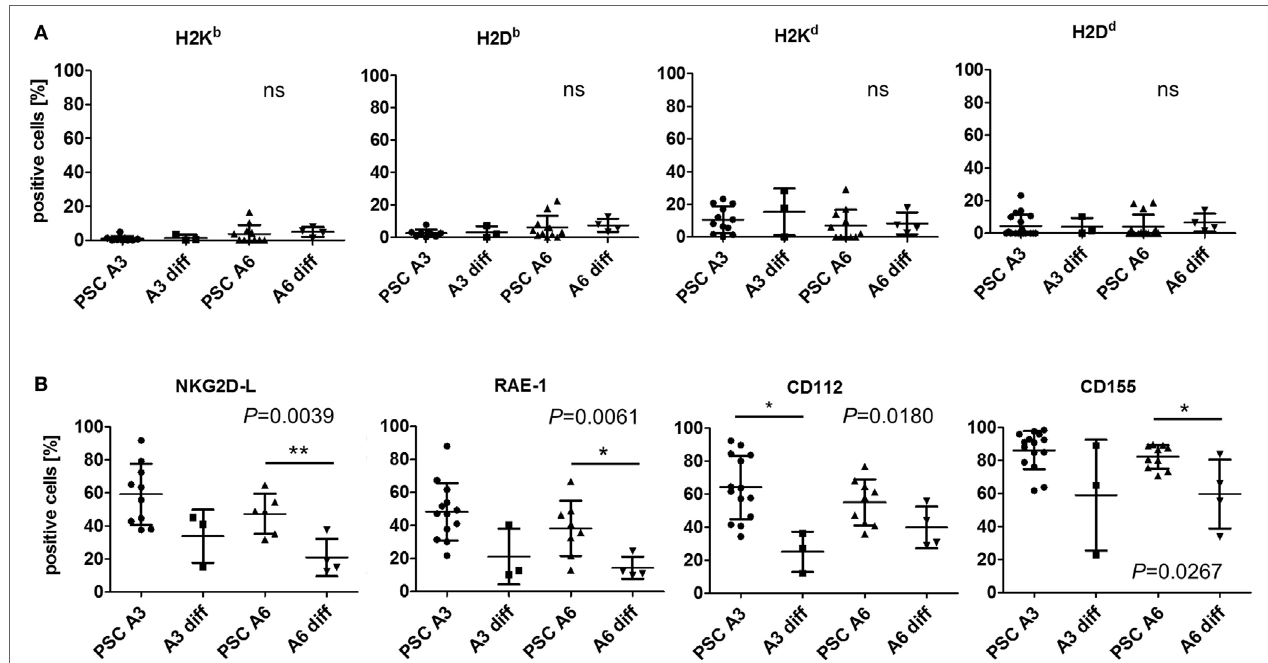
FigUre 5 | Comparison of the expression of major histocompatibility complex (MHC) class I molecules and other natural killer (NK) receptor ligands on parthenogenetic stem cell (PSC) A3, PSC A6, and in vitro -differentiated cells. The percentage of cells expressing the indicated NK receptor ligands is shown as determined by flow cytometry in 3–18 individual experiments. In addition, the mean ± SD is indicated. Differences between the cells were analyzed by Kruskal–Wallis tests and the respective P -values or non-significant (ns) results are given in the figure. Significant differences in post hoc tests between PSCs and the respective differentiated cells are indicated (** P < 0.01, * P < 0.05). (a) The expression of classical MHC class I molecules has been determined by allospecific monoclonal antibodies (mAbs). (B) The expression of ligands of the activating NK receptors NKG2D (NKG2D-L) has been determined by binding of the recombinant receptor-Fc fusion protein. Expression of the specific NKG2D ligand RAE-1 and the DNAM-1 ligands CD112 and CD155 has been analyzed by